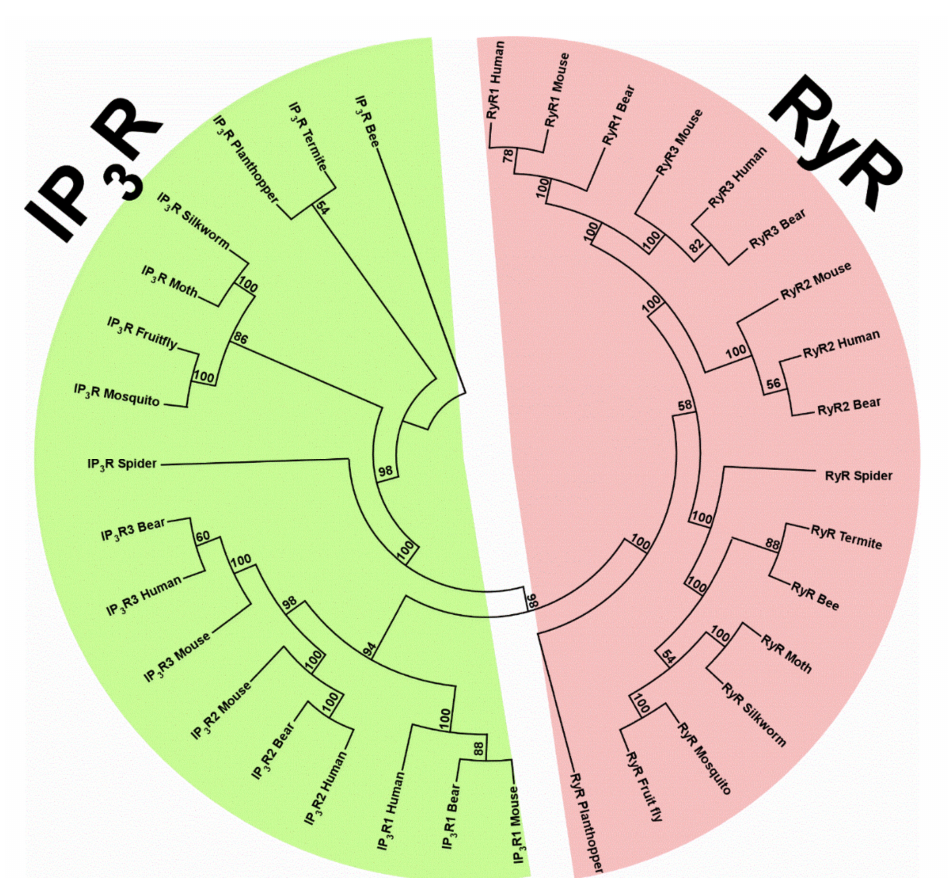
Figure 2. Phylogenetic analysis tree of IP 3 R and RyR, constructed by aligning amino acid sequences from representative species of animal phyla using the MUSCLE algorithm of MEGA-X software, version 10.0 (www.megasoftware.net) (accessed on 21 March 2021) [133]. Phylogenetic trees were constructed by using the maximum likelihood method and Le Gascuel model [134]. The bootstrap consensus tree inferred from 1000 replicates is taken to represent the evolutionary history of the taxa analyzed [135]. Branches corresponding to partitions reproduced in less than 50% bootstrap replicates were collapsed. Representative proteins and their accession numbers are given in Supplementary Table